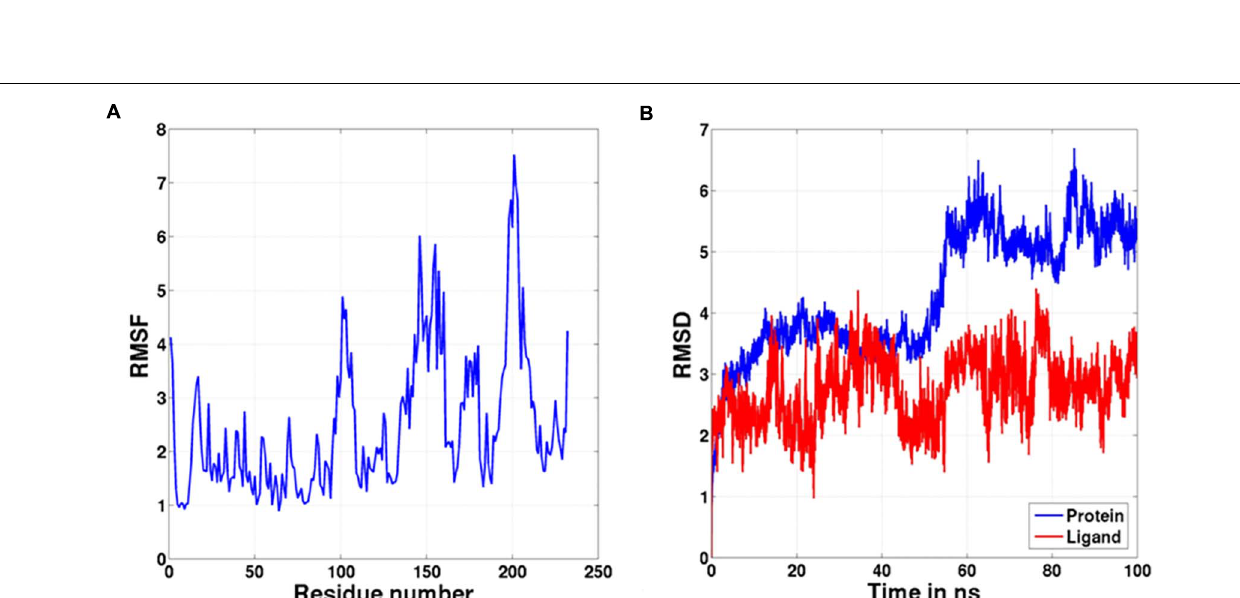
Frontiers in Microbiology |